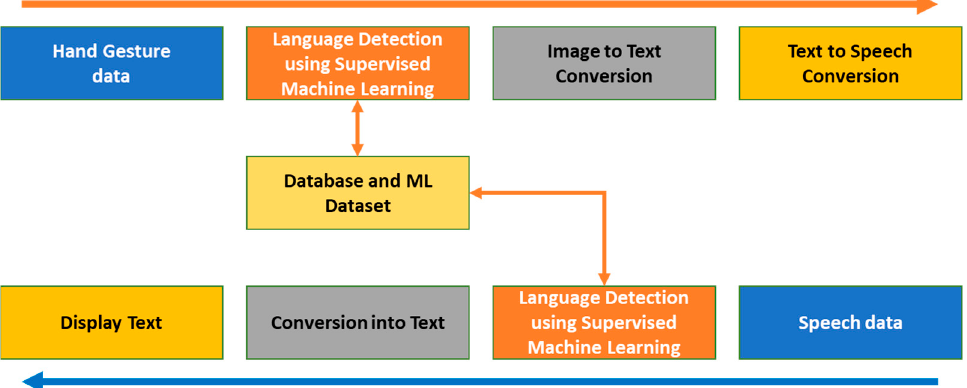
Figure 5. Software Block Diagram—Communication between DnM and NDnM.